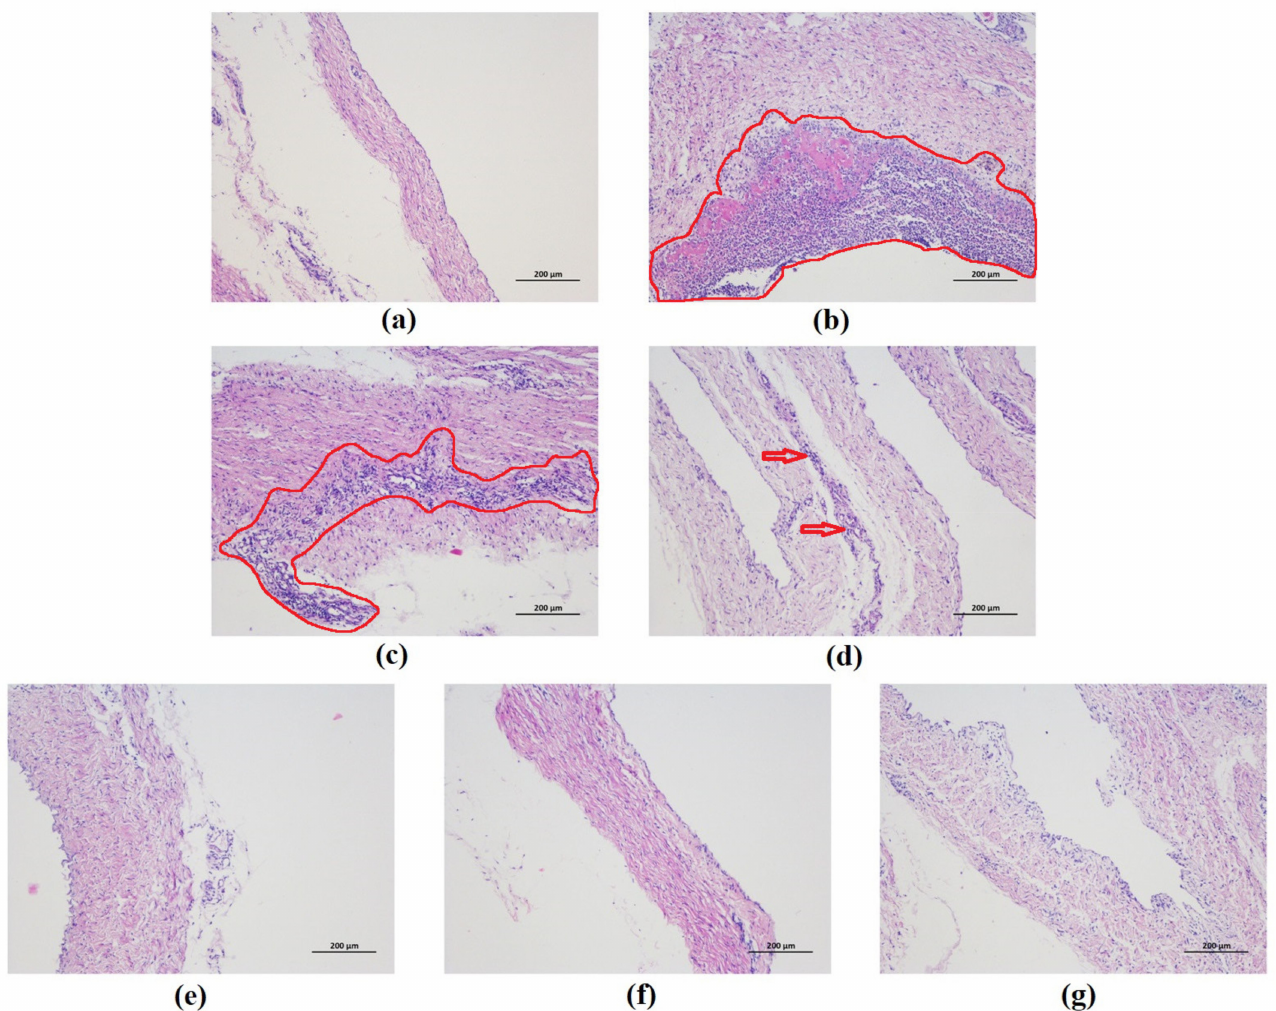
Figure 8. Histopathological change in the piglet peritoneum after G. parasuis infection (H&E, × 100). ( a ) control group, ( b ) G. parasuis group, ( c ) EP + G. parasuis group, ( d ) FM + G. parasuis group, ( e ) 25 mg/kg baicalin + G. parasuis group, ( f ) 50 mg/kg baicalin + G. parasuis group, ( g ) 100 mg/kg baicalin + G. parasuis group. Severe and moderate lesions were circled with red line. Mild lesions were pointed by red